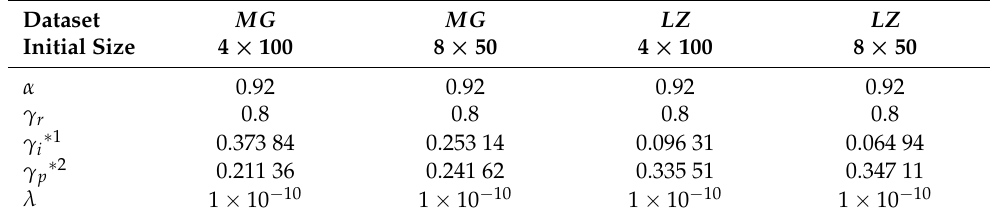
Table A1. Hyperparameters applied under different initial reservoir sizes on different